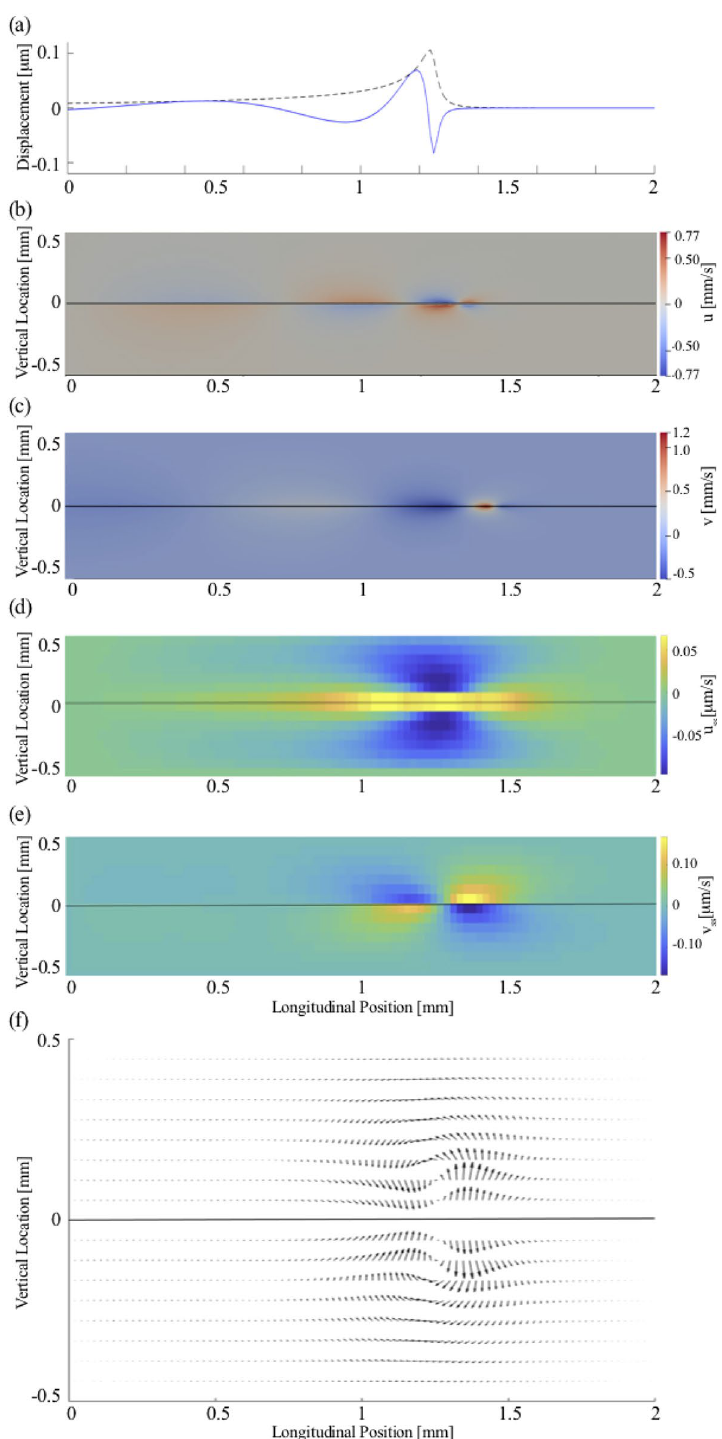
Figure 3. Steady streaming induced by a pure tone of 20 kHz at 80 dB SPL. ( a ) The wave on the basilar membrane (blue line) has a wavelength that shortens upon approaching the resonant position. The wave amplitude (black dashed line) peaks at the resonant position. OpenFOAM results for the instantaneous longitudinal ( b ) and vertical ( c ) fluid field velocity components, ( u , v ) which are both largest near the resonant position. ( d ) The longitudinal component of the steady streaming, u ss , is largest near the peak of the basilar- membrane wave as well. Near the membrane, the velocity is oriented towards the apex, and further away from the membrane particles move towards the base. ( e ) The vertical streaming velocity, v ss points towards the membrane basal to the wave’s peak, and away from the membrane apical to the peak. ( f ) The steady streaming flow field shows two counter-rotating vortices, one in the upper and one in the lower